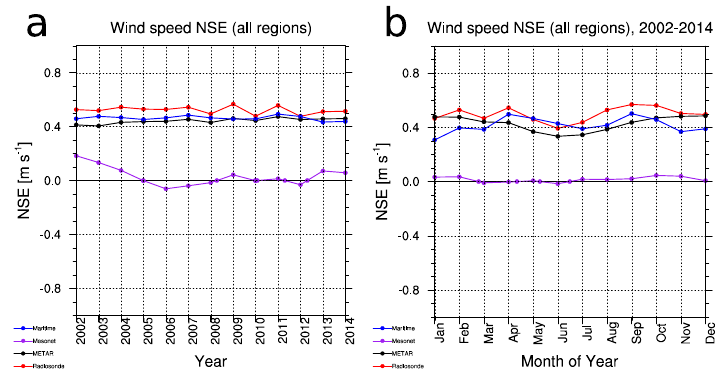
Figure 11. As in Figure 10, but for mean error.